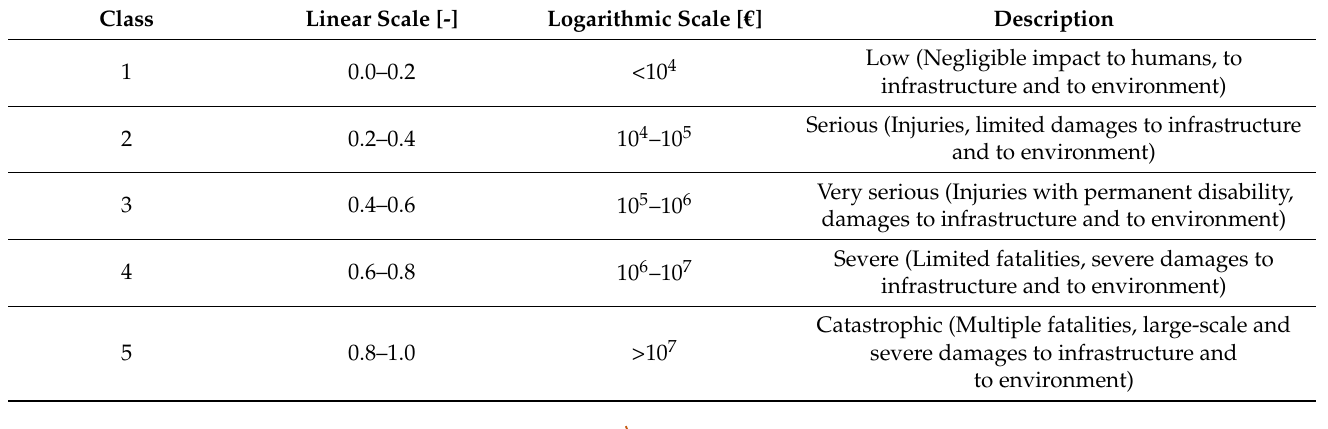
Table 1. Five level consequence scale [10].